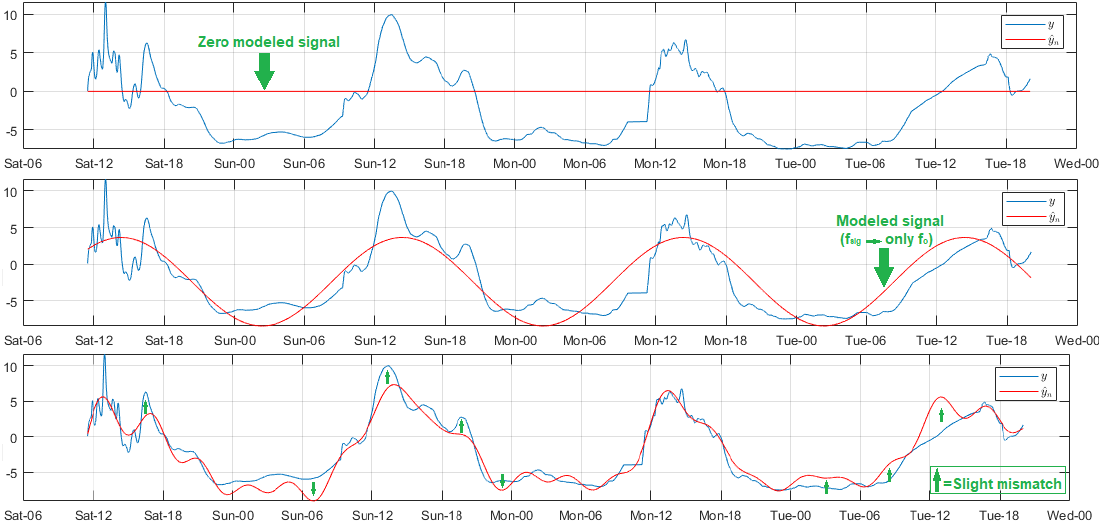
Figure 9. Representative modeled signals of wind speed. From top to bottom: Reg = 4, 5, and 12.